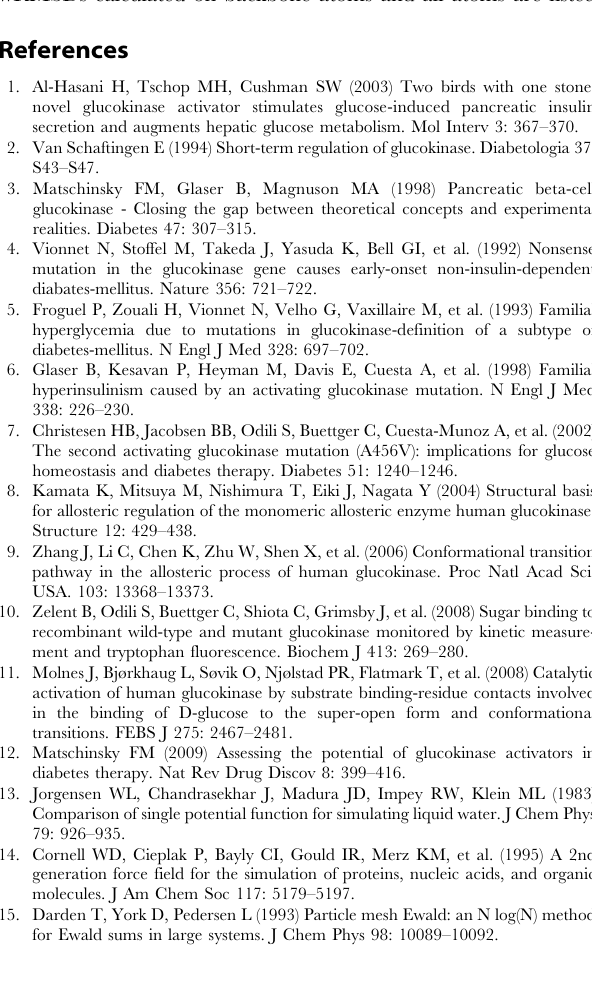
on GK. (A) Time dependency of RMSD from free GK in the 50- ns MD simulation. (B) Cleft angle profile along the 50-ns trajectory. The angle is defined by two lines from the C a atom of Cys233 (hinge residue) to the C a atoms of Gly229 and Lys169 (9). Table S1 wRMSDs between trajectories using different initial velocity under the restraint force of 0.5 kcal ?- mol 2 1 ? A˚ 2 2 . wRMSDs calculated on backbone atoms and all atoms are listed on the upper triangle and lower triangle of the table. Data in the parentheses are variance of wRMSD between two trajectories Table S2 wRMSDs between two trajectories using different forces of 0.5, 1.0, 1.5 and 2.0 kcal ? mol 2 1 ? A˚ 2 2 . wRMSDs calculated on backbone atoms and all atoms are